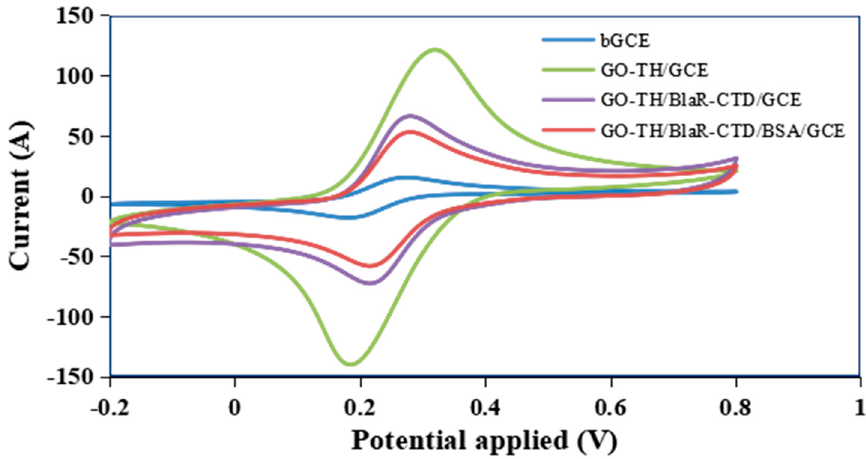
Figure 3. The cyclic voltammetry (CV) diagram of electrode in self-assembly process.